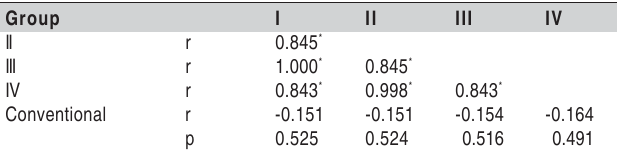
Table 3. Pearson’s correlation coefficient for mean values of radiographic contrast among all image groups.